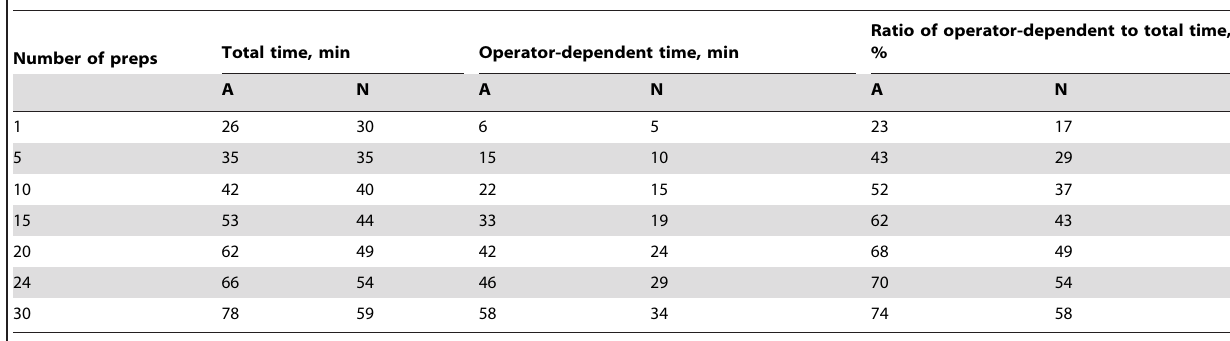
Table 1. Time requirements of alkali vs. NID plasmid